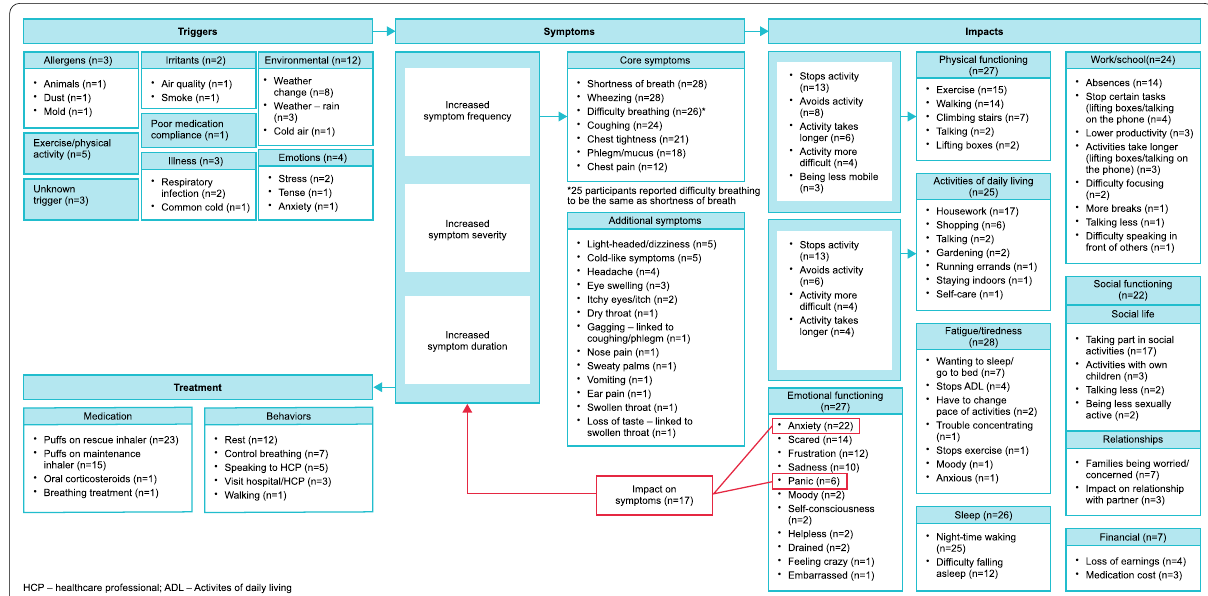
Fig. 4 Conceptual model of the patient experience of a moderate asthma attack (moderate exacerbation) a . a Model was developed based on interviews with 8 German and 20 USA patients and on ATS/ERS definition of a moderate exacerbation. ATS American Thoracic Society; ERS European Respiratory